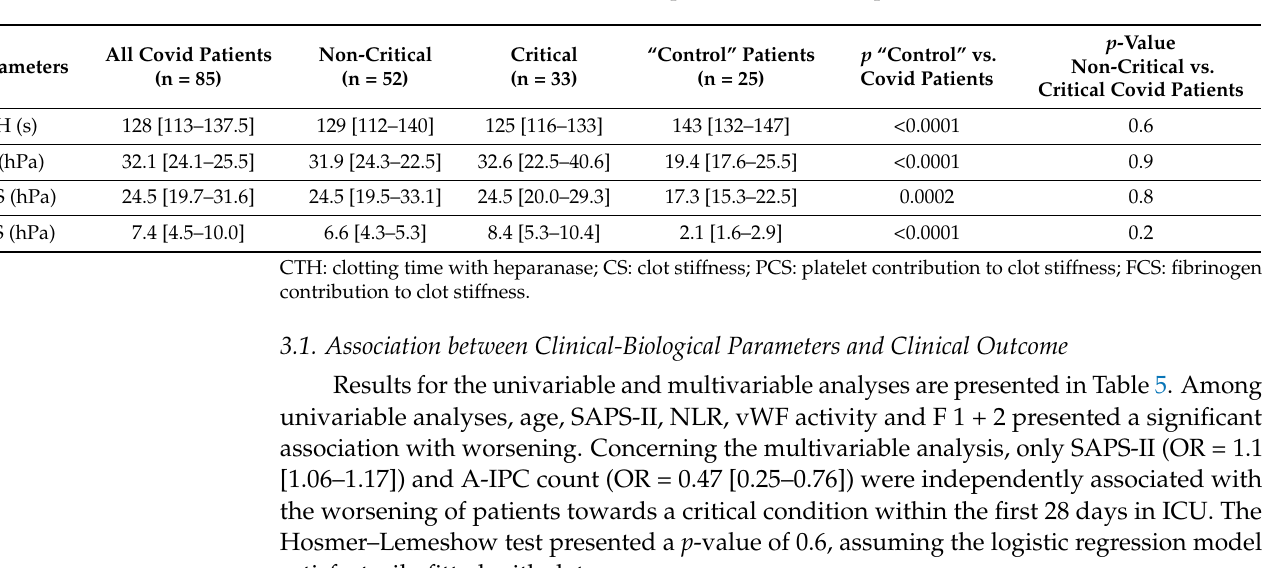
Table 4. Viscoelastic tests of COVID-19 patients and control patients.